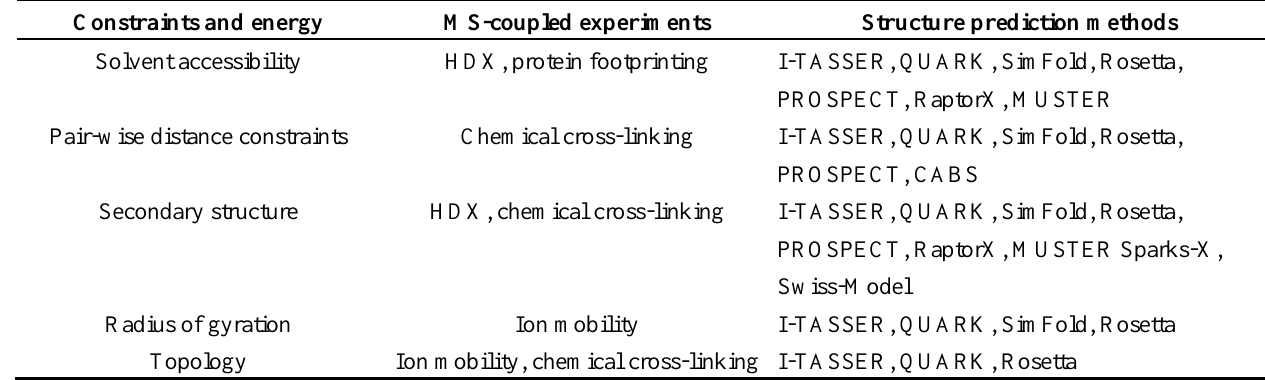
Table 5. Constraints and energy terms and their